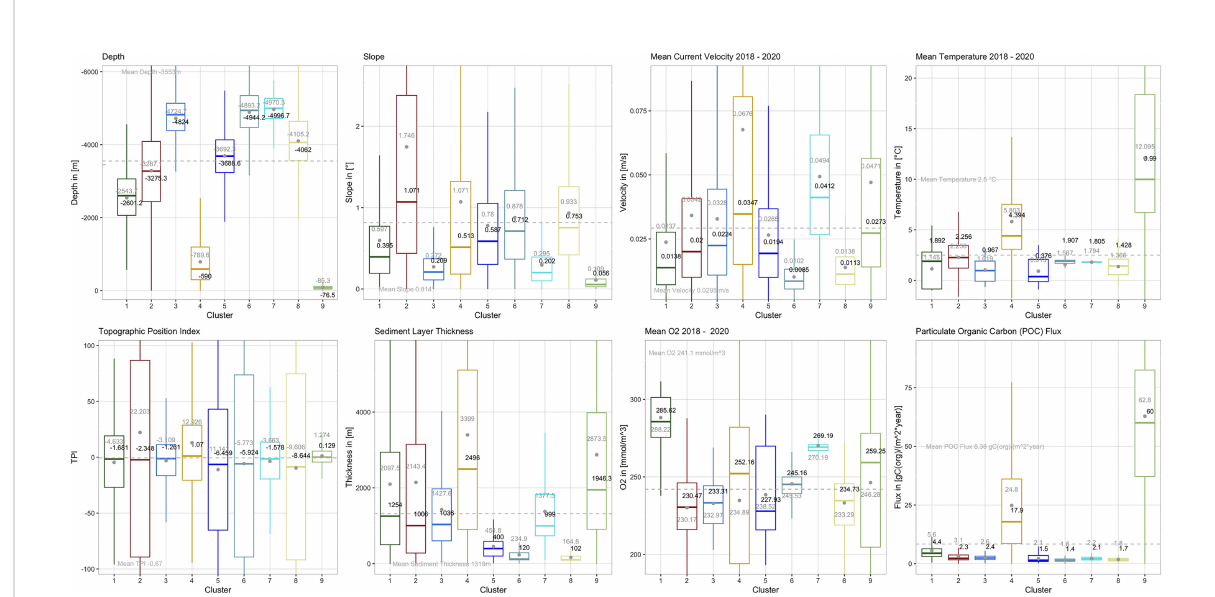
FIGURE 2 Boxplots outlining the SBA characteristics. The boxes comprise the groups ’ interquartile ranges, i.e. between the upper (75%) and lower (25%) quartiles and contain the central 50% of the data. The ‘ whiskers ’ (straight lines below and above the box) denote minimum and maximum data values, and together with the boxes make up 95% of the data set. The remaining 5% are extreme values, which for better visibility are not shown here. They can be found in boxplots of the supplementary material F2. The colored lines/grey dots inside the boxes indicates the groups ’ median/mean, whereas the grey dashed line is the overall data set ’ s median.